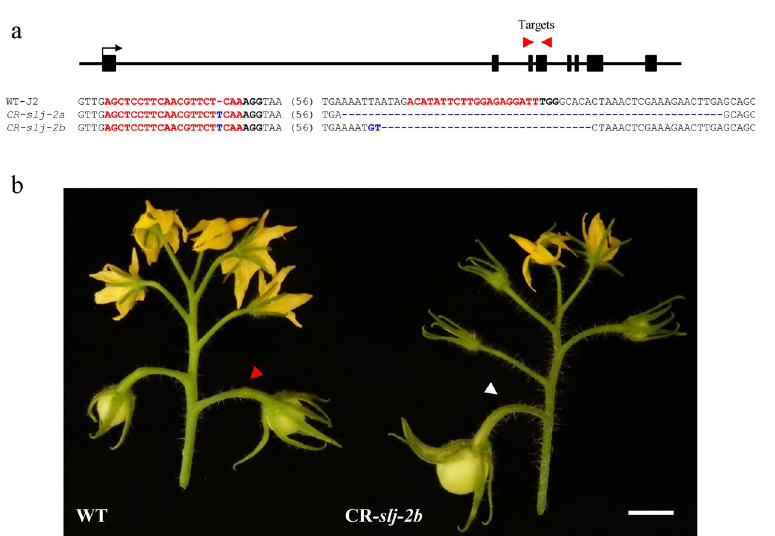
Figure 5. A CRISPR/Cas9-engineered mutation in J-2 gene abolishes development of the flower AZ. ( a ) Two sgRNAs (red arrows) were designed to target the second and third exons of the J-2 gene. Types of DNA lesions generated in two T1 CRISPR/Cas9 J-2 (CR- slj-2 ) plants and identified by PCR genotyping from loss-of-function alleles CR- slj-2a and b (bold red: sgRNA targets, bold black: PAM site, dashes: deleted nucleotides, blue letters: inserted nucleotides). ( b ) Representative inflorescence of WT and CR- slj-2b mutant. Arrows indicate the AZ in WT (red) or the expected place of AZ in CR- slj-2b (white).